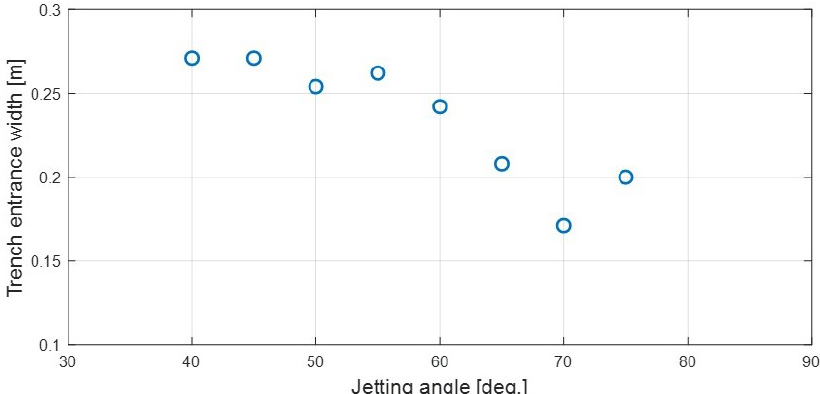
Figure 7. Jetting angle vs. trench entrance width.